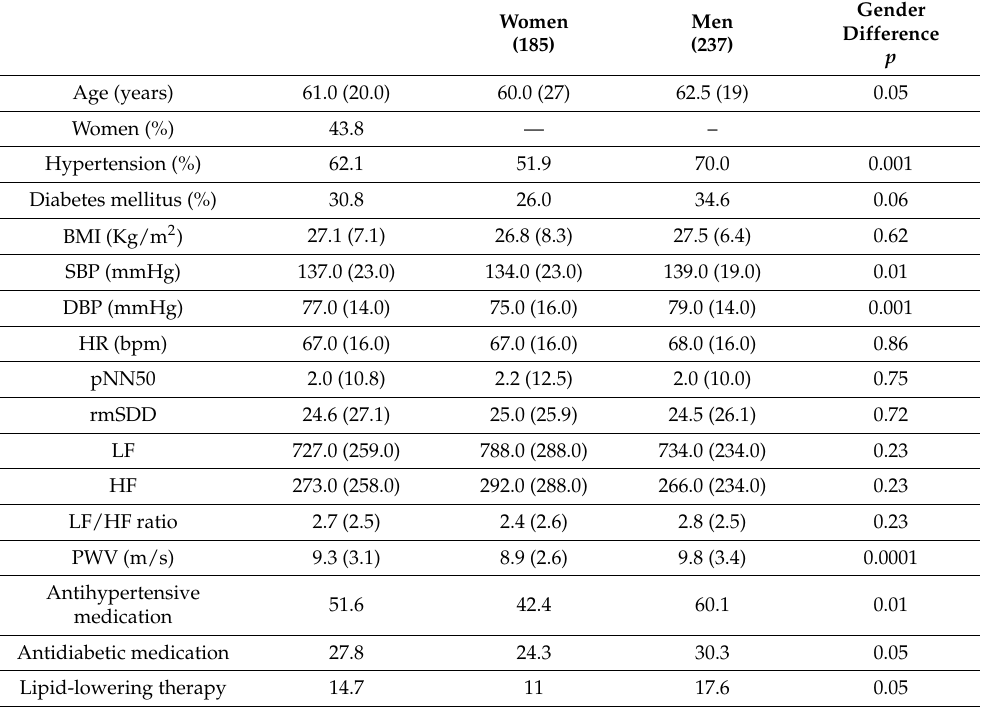
Table 1. Characteristic of study population according to sex (median values and interquartile